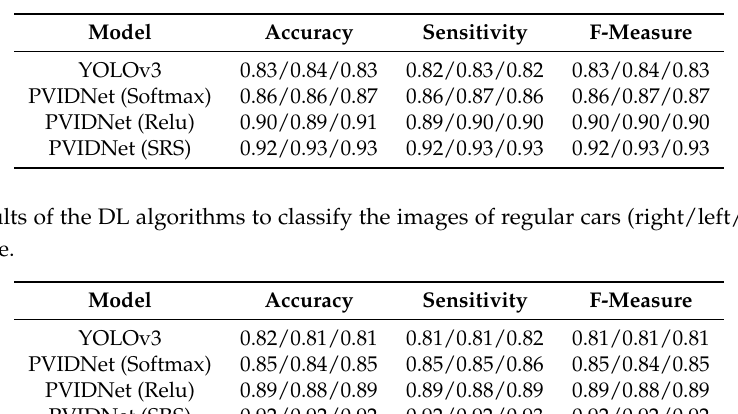
Table 8. Results of the DL algorithms to classify the images of police cars (right/left/front) in the training phase.